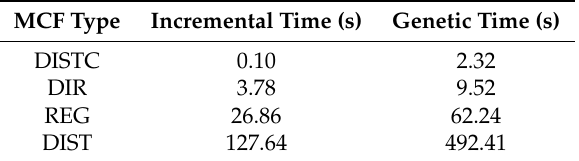
Table 13. Average times of execution for different MCFs for remote eye tracker.